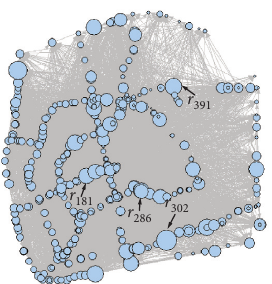
Figure 15: Spatial locations of critical road segments.